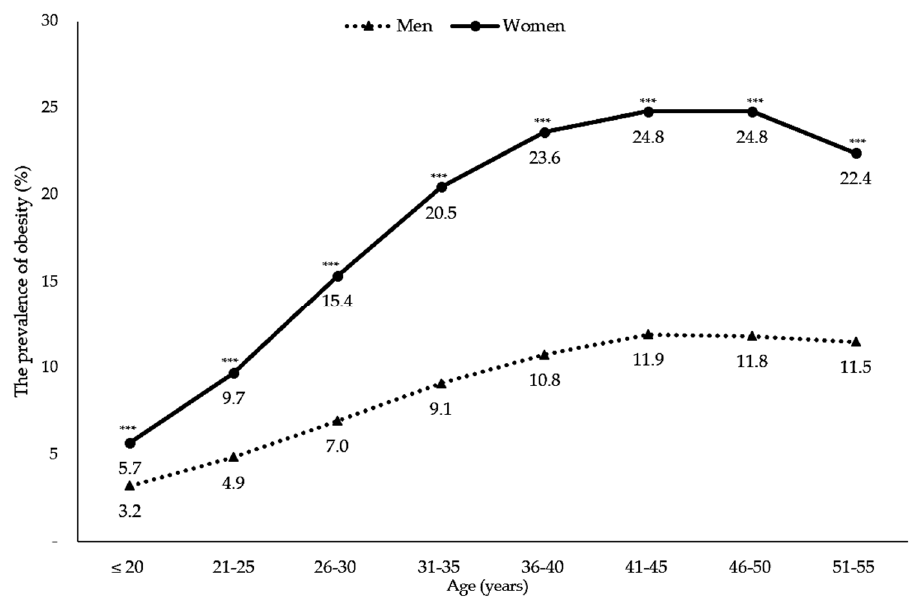
Figure 2. The prevalence of obesity by age. Footnote: *** p value < 0.0001.